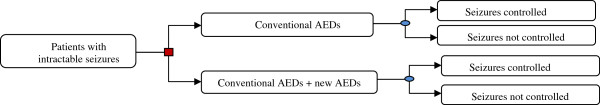
Decision tree of adding-on new AEDs to conventional regimens.